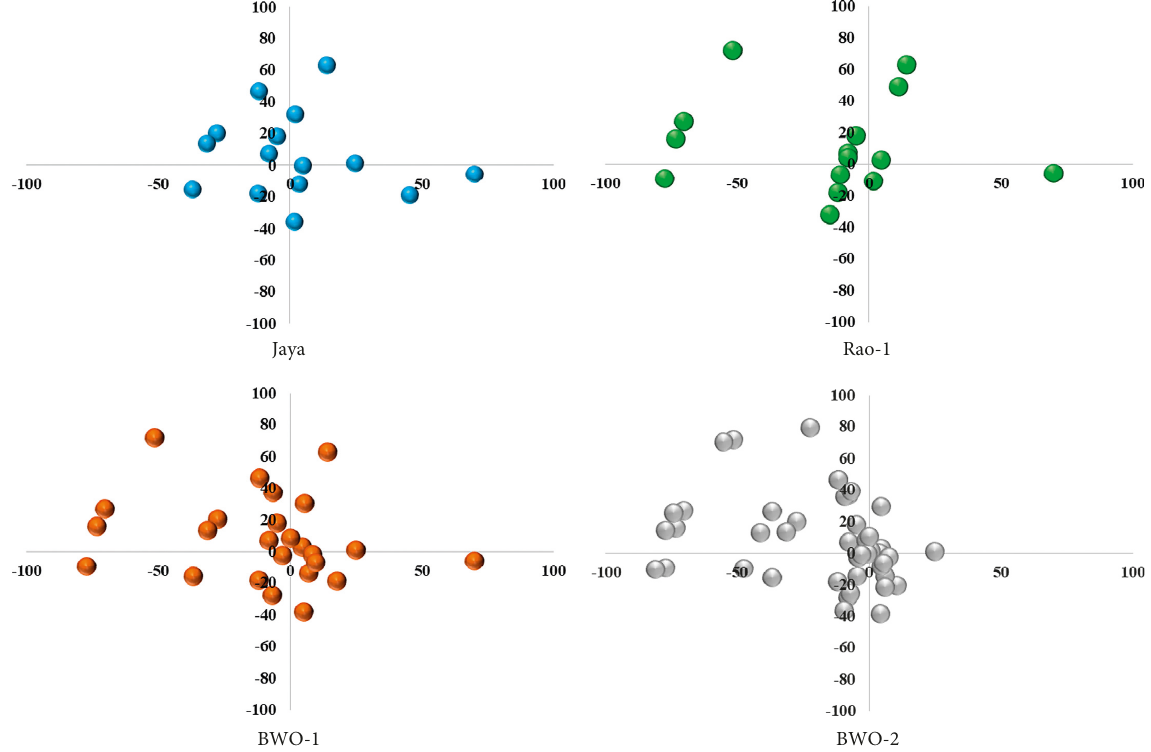
Figure 8: Search the history of agents for the Jaya, Rao-1, BWO-1, and BWO-2